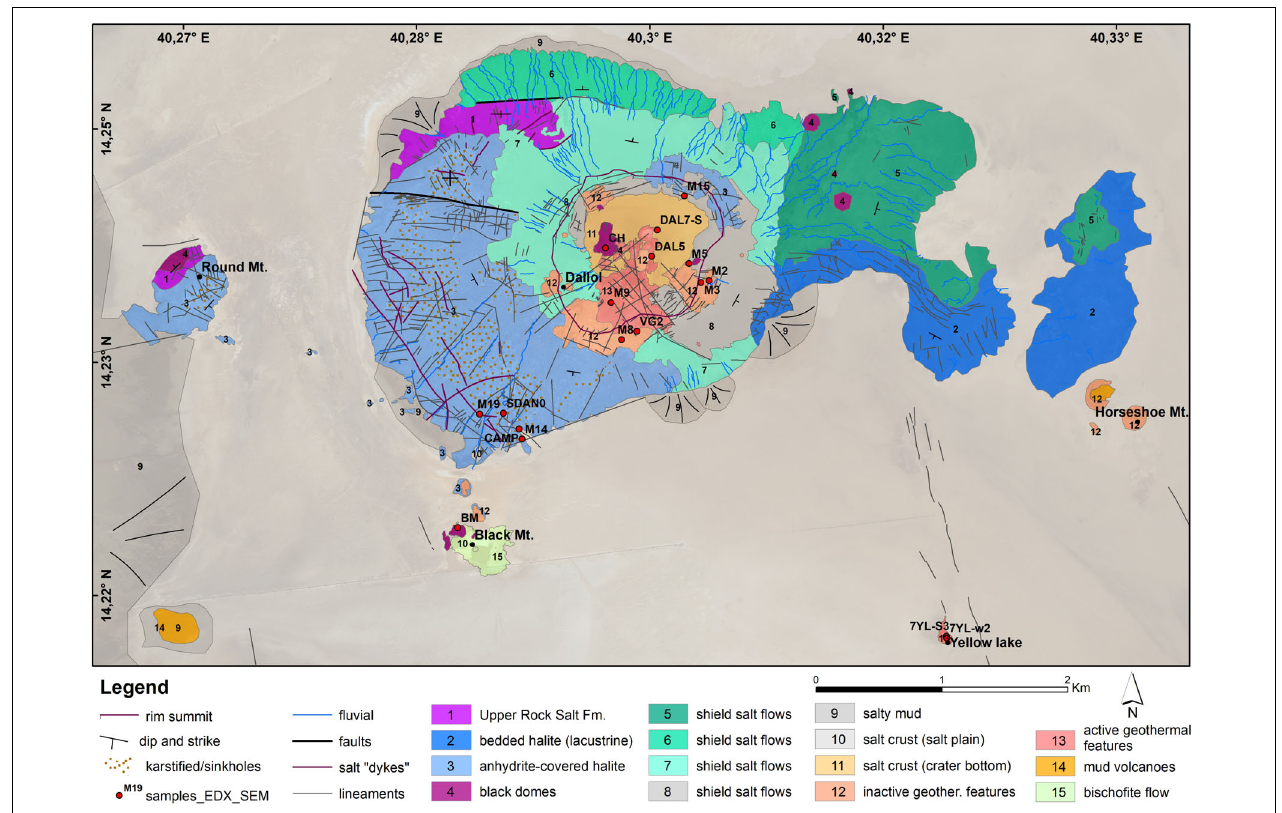
FIGURE 5 | Detailed geological map of the Dallol complex and sample site locations. Sample sites are described in Table 1